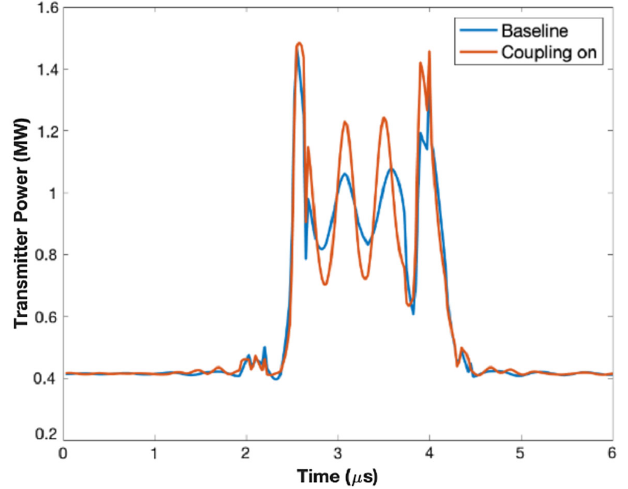
FIG. 16. Transmitter power for three-section cavity with coupled feedback.